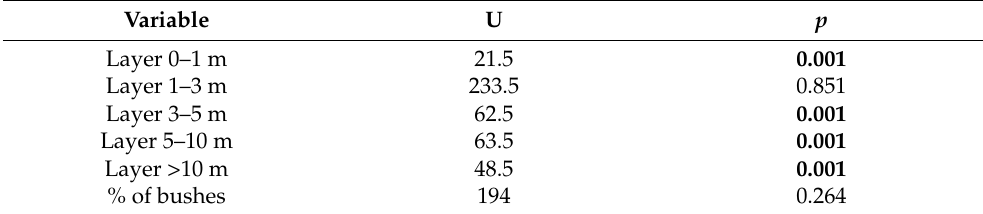
Table 1. Results of the comparison of cover for each vegetation stratum between forest and pasture points ( n = 44), Mann-Whitney U test. Significant differences are provided in bold.